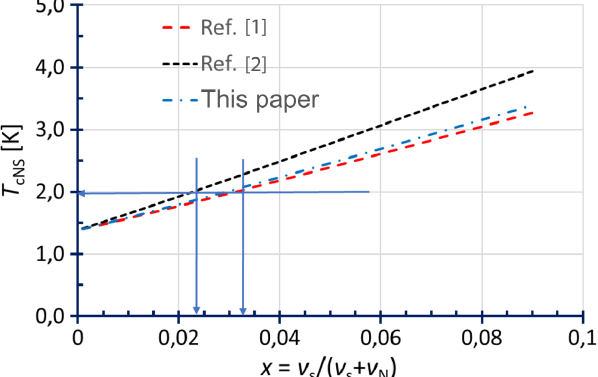
FIG. 1. Critical temperature of the Nb = NbO composite in the Cooper limit of the proximity effect vs the volume fraction x ¼ þ v Þ of the S component v = ð v S N S